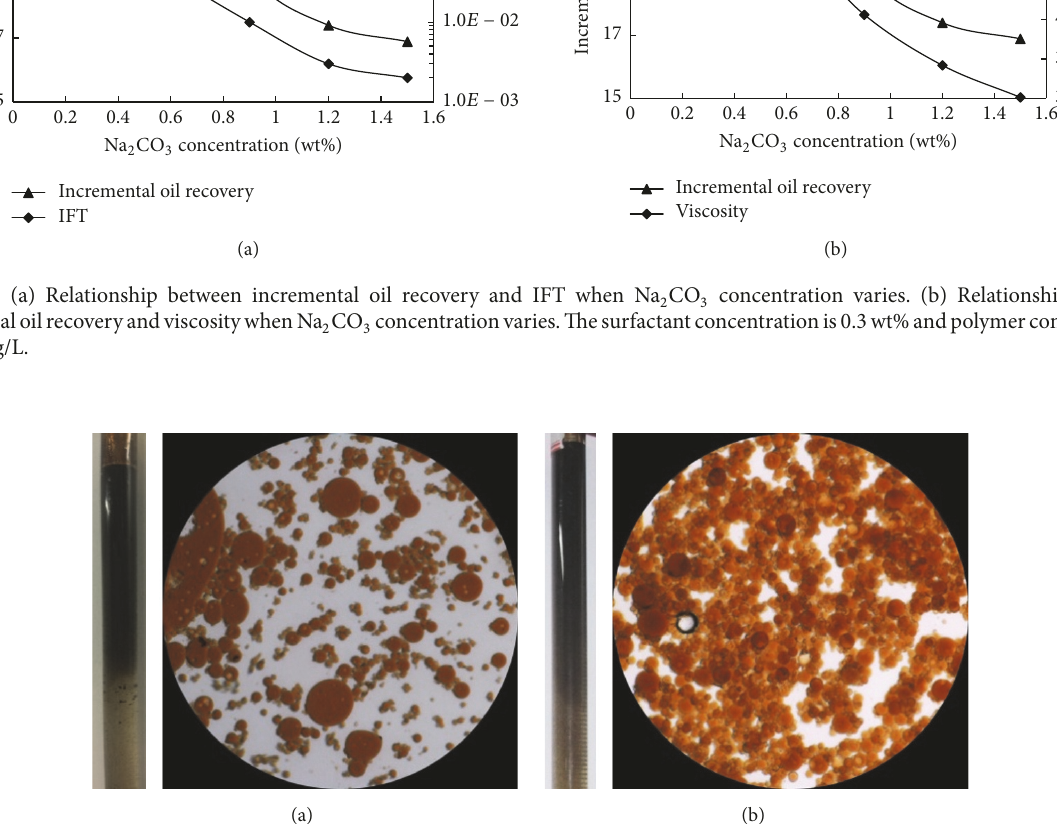
Figure 9: Micrographs of produced fluids in different production periods when chemical solution was injected: (a) in the earlier production period; (b) in the later production